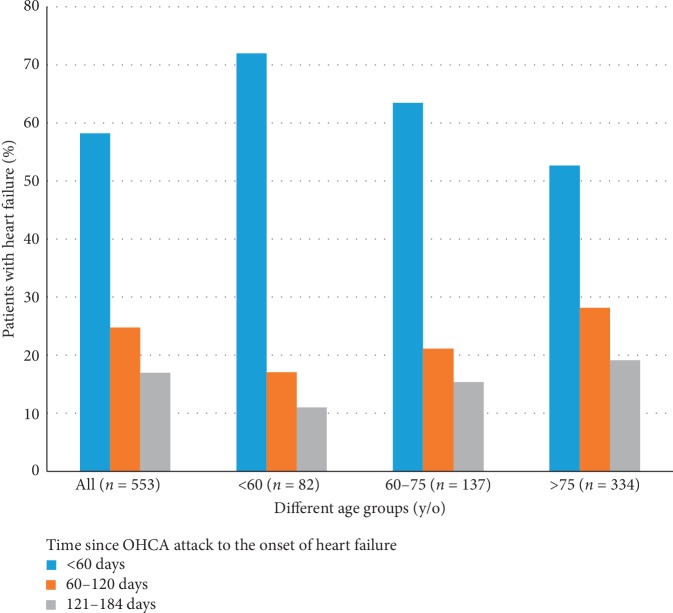
The time between OHCA and new-onset heart failure.